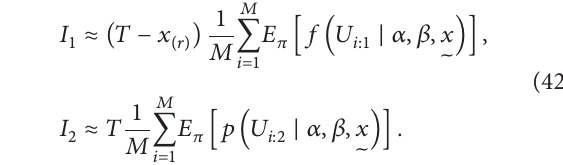
𝐸 𝜋 denotes the expectation of the function with respect to the joint posterior pdf of 𝛼 and 𝜆